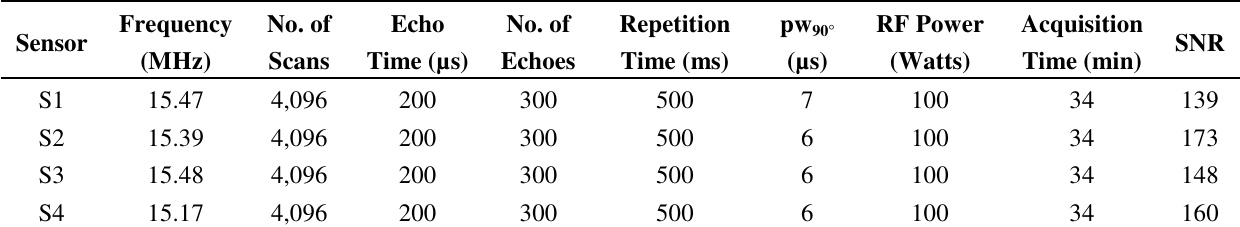
Table 1. CPMG parameters used to obtain the SNR for each sensor using a polymer phantom, which has a long lifetime component of 20 ms and a short lifetime component of 4.5 ms.